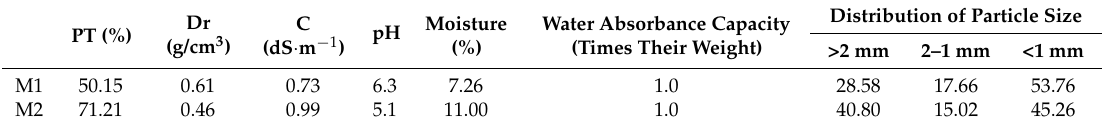
Table 1. Physicochemical characterization of the two substrate